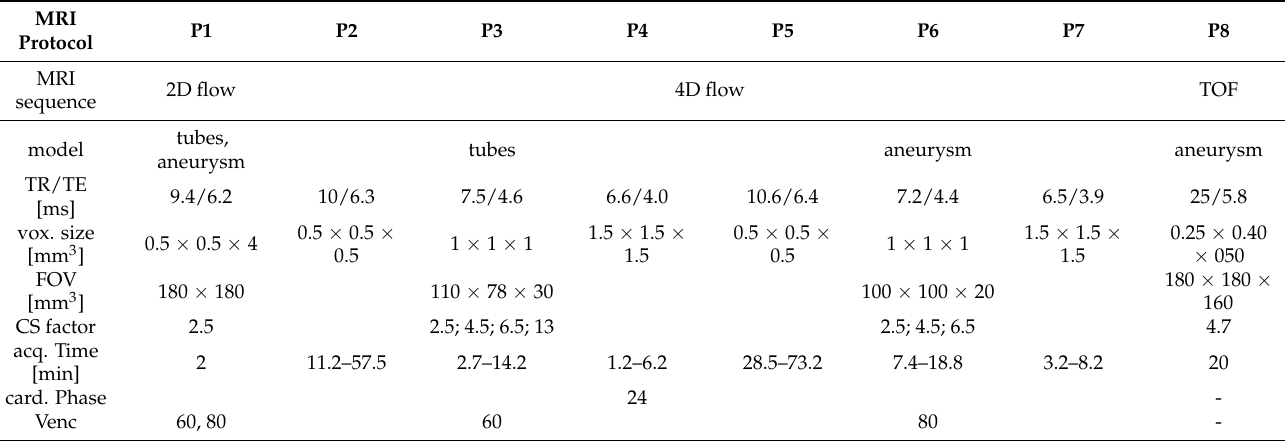
Table 1. Protocol parameters for the in-house 2D and 4D flow and TOF MRI sequences modified from the vendor